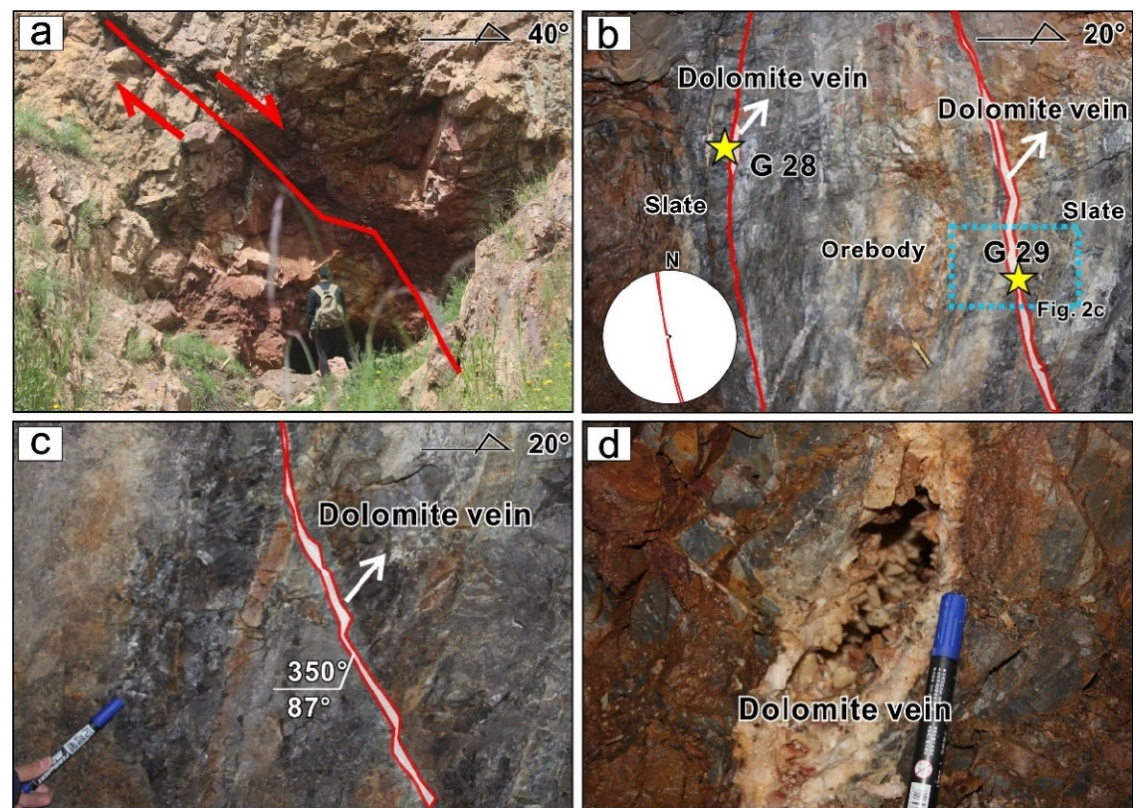
Figure 2. Field photographs to show ( a ) the fault and associated small-scale features in Gelouang gold deposit. ( b ) Exposure of the fault from underground works that indicate dolomite veins crosscut the altered slate and orebodies. ( c , d ) Close-up view on the fault plane.